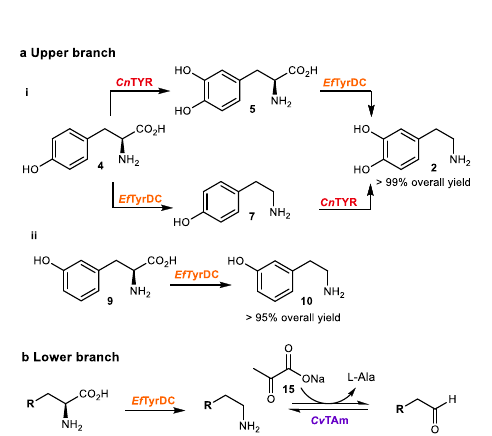
Fig. 2 | Designing the parallel cascade. a The upper branch to arylethylamines. i. Dopamine 2 wasgeneratedinaone-pottwostepcascadereactionfromL-tyrosine 4 combining Cn TYR and Ef TyrDC; ii. Meta -tyramine 10 was produced from meta - tyrosine 9 by Ef TyrDC; Reaction conditions i: a 1mL of reaction mixture (50mM HEPES, pH 5.5) containing 4 (2.5mM, 1 equiv.), 0.4 mgmL − 1 cell lysate of Cn TYR (containing 21% of recombinant protein), 0.4 mgmL − 1 cell lysate of Ef TyrDC (con- taining 25% of the recombinant protein), sodium ascorbate 8 (4 equiv.), CuSO 4 (40 μ M)andPLP(1.25mM)at25°C,250rpmfor6handquenchedbyadding1 μ Lof tri fl uoroacetic acid (TFA). ii: a 1mL of reaction mixture (50mM HEPES, pH 7.5) containing 7 (2.5mM,1equiv.),0.4mgmL − 1 celllysateof Ef TyrDC(containing25%of therecombinantprotein),sodiumascorbate 8 (1equiv.)andPLP(1.25mM)at25°C, 250rpm for 6h, and quenched by adding 1 μ L of TFA). b The lower branch to